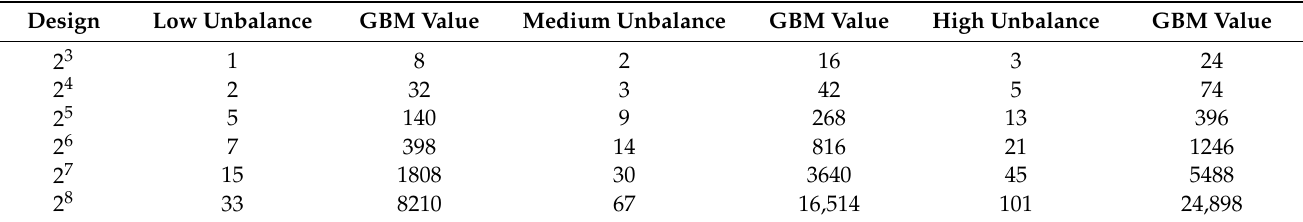
Table 2. Number of rows to be modified to achieve a desired level of unbalance.